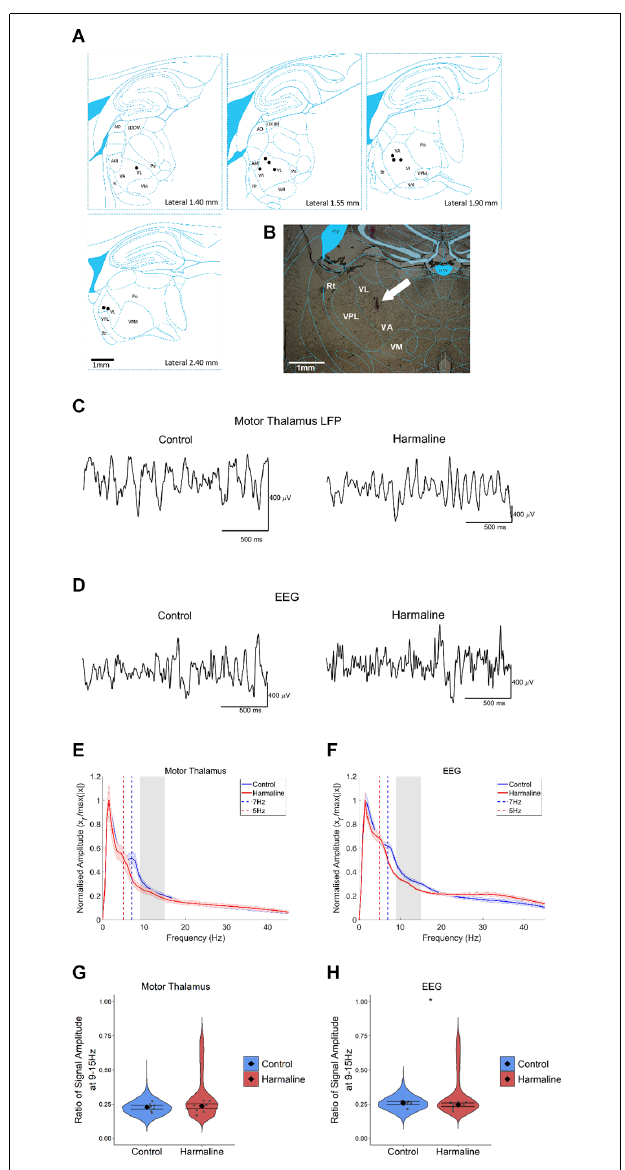
FIGURE 3 | The amplitude of oscillations at the tremor frequency in the thalamocortical circuits. (A) Summary diagram illustrating approximate electrode positions on sagittal sections of the thalamus (adapted from Paxinos and Watson, 2005), where each black dot represents the approximate electrode positioning per rat and the VA/VL complex of the thalamus (i.e., motor thalamus). (B) Example coronal section from one rat with electrode approximately located in the VA/VL complex of the thalamus. The arrow indicates the approximate position of the tetrode tip. (C,D) Representative LFP traces from (C) motor thalamus and (E) EEG during pre-harmaline control and harmaline. (E,F) Mean ( ± SE) amplitude spectrum for (E) motor thalamus ( n = 9 rats) and (F) EEG ( n = 9 rats) during control and harmaline. The solid line represents mean amplitude, and the coloured shaded areas represent SE. The grey area represents the tremor frequency. (G,H) Ratio of amplitude at the tremor peak for (G) motor thalamus and (H) EEG, where the violin plots show the distribution of this ratio across all epochs (pooled across rats). Individual grey points represent the mean per rat. Fixed effects parameter estimates ( ± CI) representing predicted mean estimates are shown by (cid:7) and corresponding error bars. ∗ indicates p <